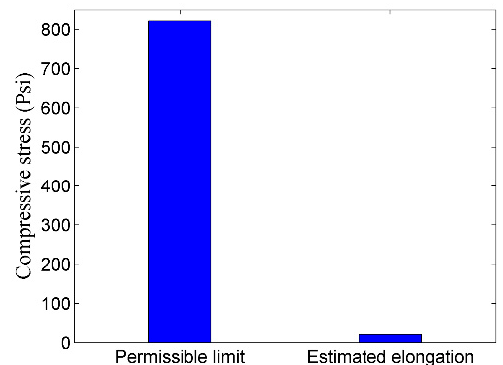
Figure 10. Comparison of permissible and actual wall compressive stress for the proposed scheme.